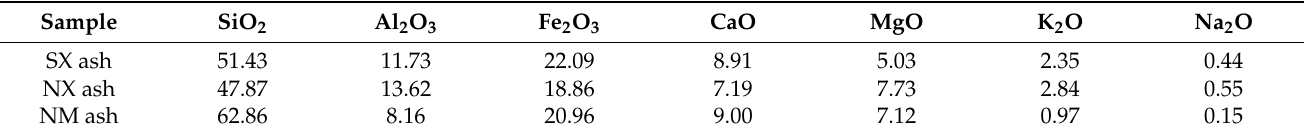
Table 2. Inorganic constituents of the coal sample.